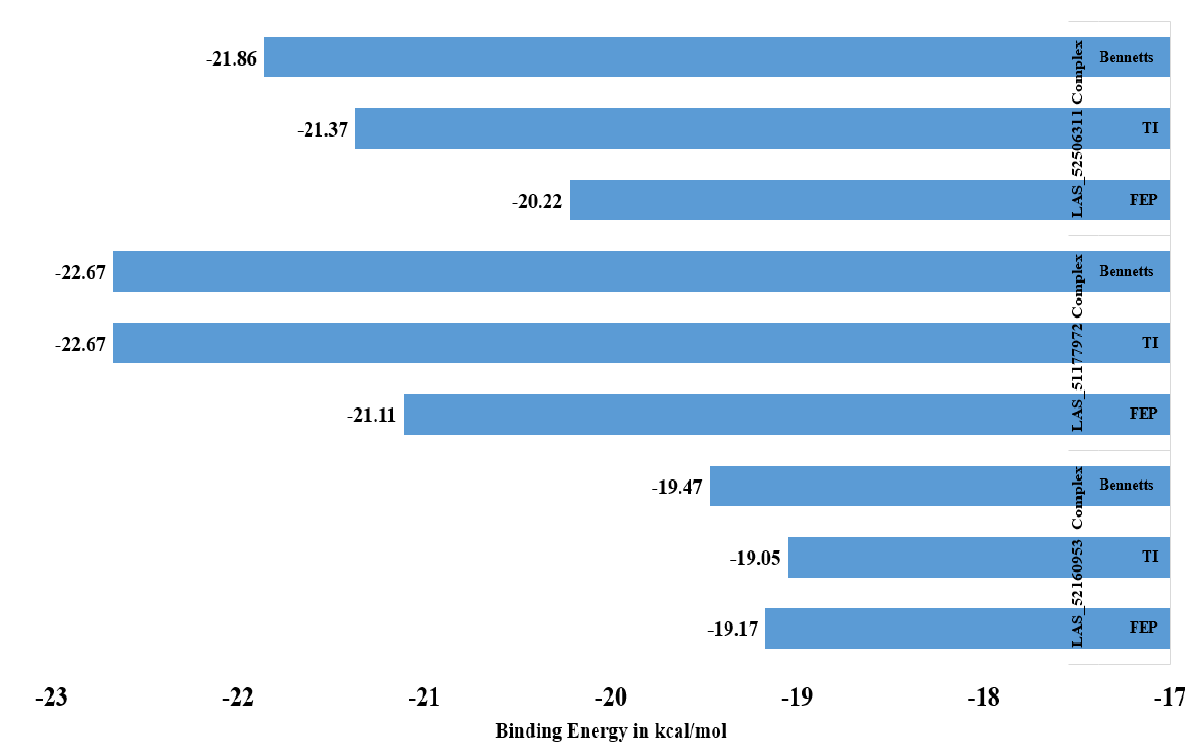
Figure 3. WaterSwap analysis energy values of complexes.